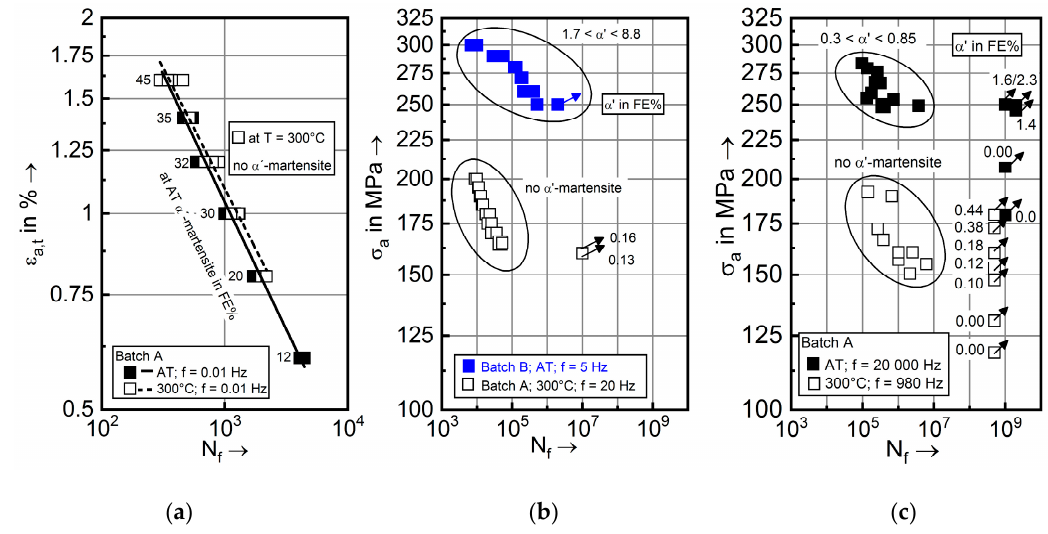
Figure 12. ( a ) ε a,t –N curve in LCF regime of batch A at AT and T = 300 °C, ( b ) S-N curve in HCF regime of batch A at T = 300 °C and batch B at AT, ( c ) S-N curve in VHCF regime of batch A at AT and T = 300 °C.